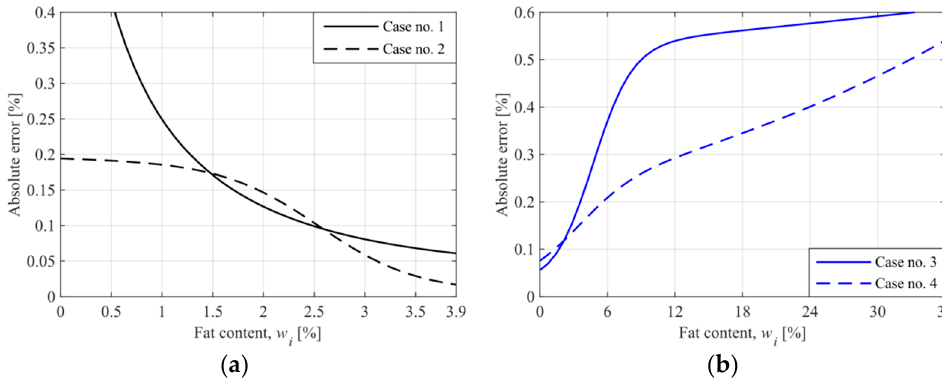
Figure 11. The absolute error of measurement for the milk samples (( a )—cases no. 1 and 2, for the operating point at 3.9%, ( b )—cases no. 3 and 4, for the operating point at 0%).